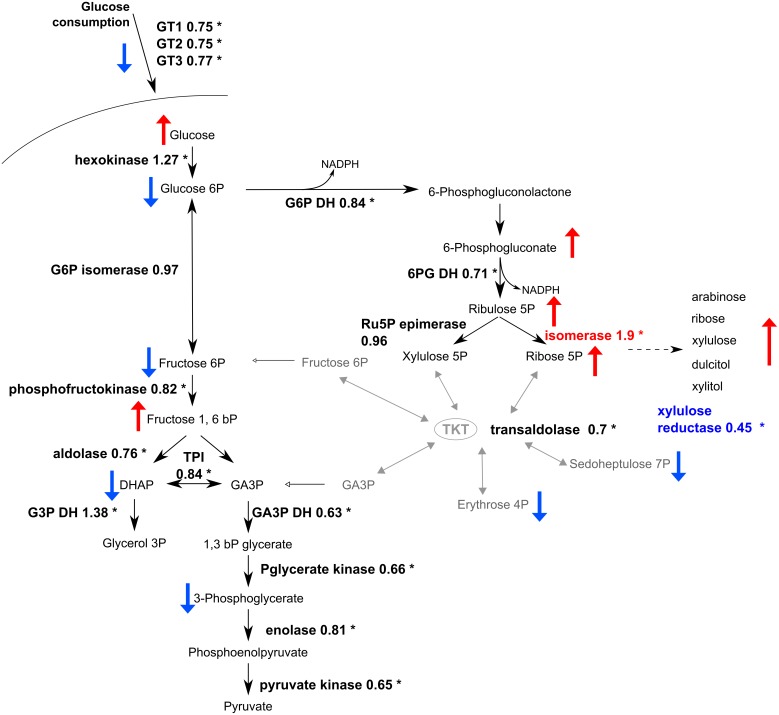
Relative shift in mRNA levels detected for the respective enzymes in glycolysis and the PPP by RNAseq analysis.Relative values detected in Δtkt when compared to WT are indicated. mRNA increased more than two fold is indicated in red, and decreases of more than two fold in blue, respectively. Red and blue arrows accompanying metabolites represent results of the GC-MS analysis, as depicted in Fig 4B. * p < 0.001.